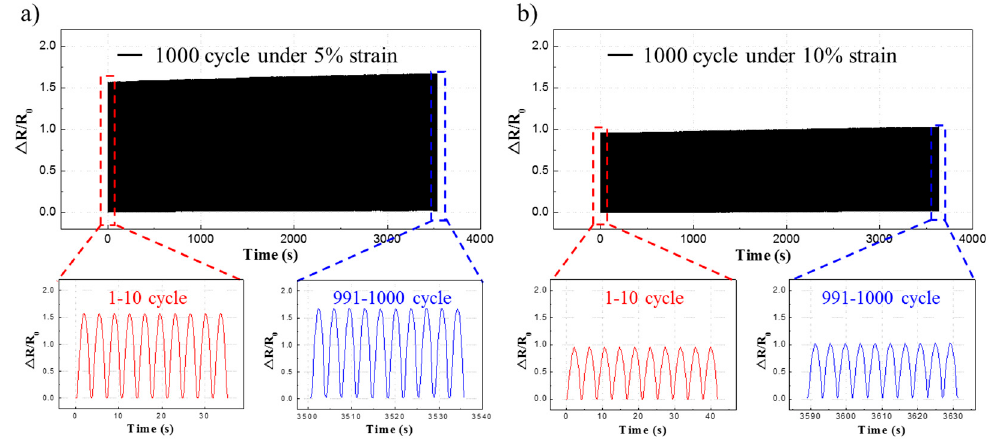
Figure 8. Repeated loading / unloading tests. ( a ) Result of repeated tensile tests of the longitudinally aligned flexible strain sensor. ( b ) Result of repeated tensile tests of the laterally aligned flexible strain sensor.